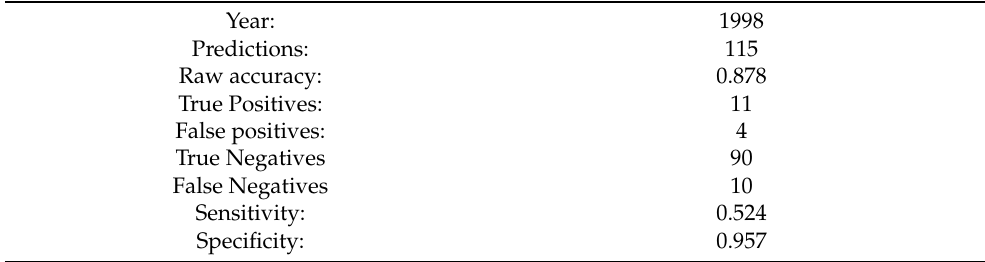
Table 3. Random forest metrics for the target dataset.